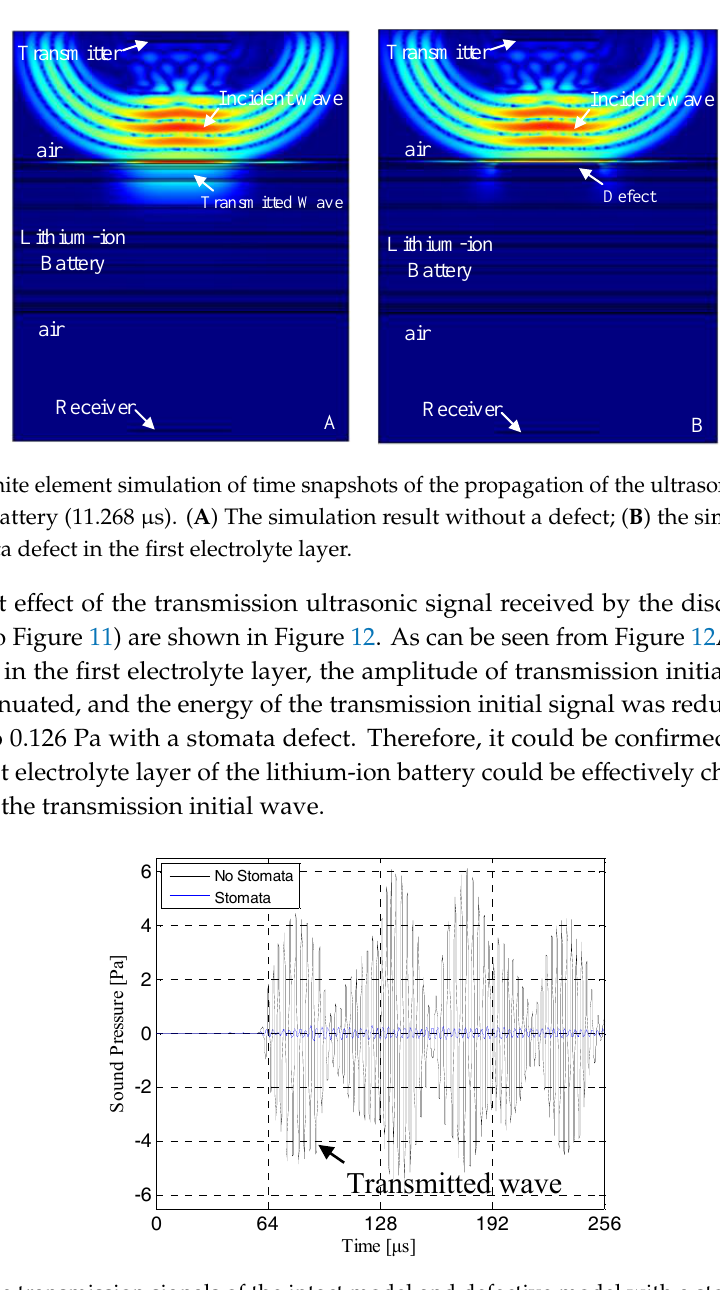
Figure 12. The transmission signals of the intact model and defective model with a stomata defect in the first electrolyte layer.